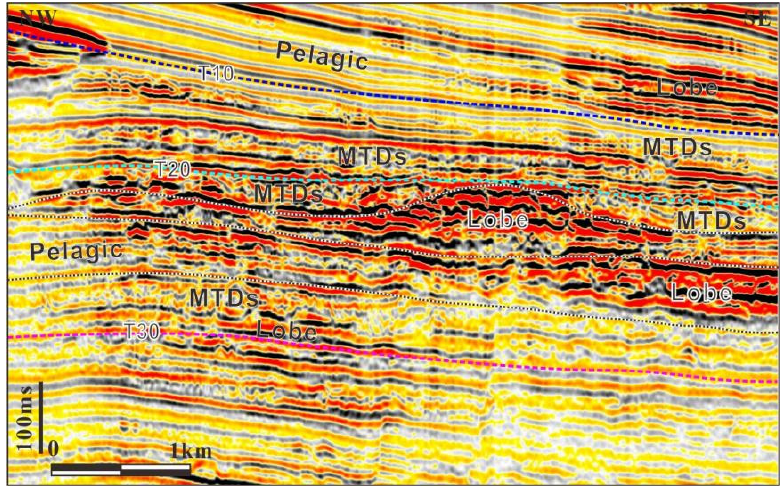
Figure 5. Successive MTDs and turbidity lobes developed outside the distal mouth of canyons. Turbidity Lobe